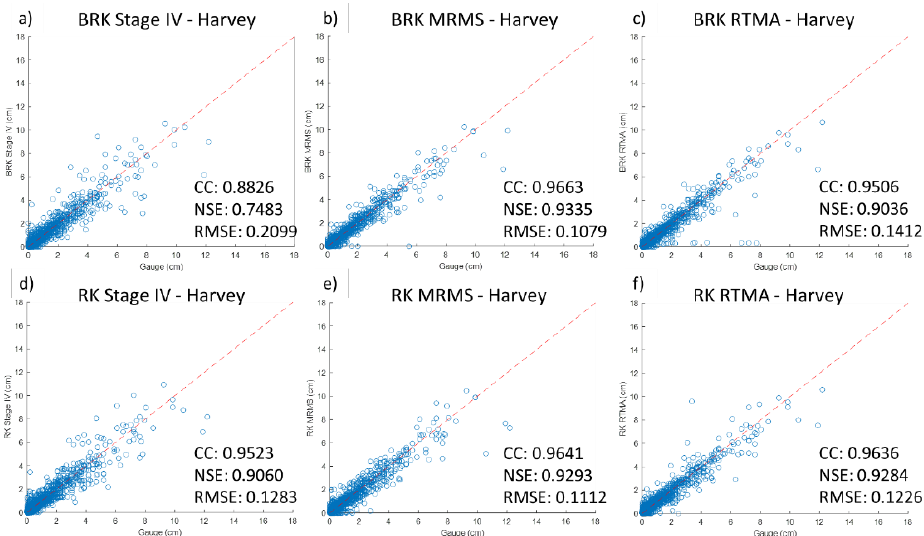
Figure 8. Scatter plots of calibration gauge data and merged radar-gauge data of ( a ) Stage IV, ( b ) MRMS, ( c ) RTMA using the BRK method, ( d ) Stage IV, ( e ) MRMS, and ( f ) RTMA using the RK method during Hurricane Harvey.